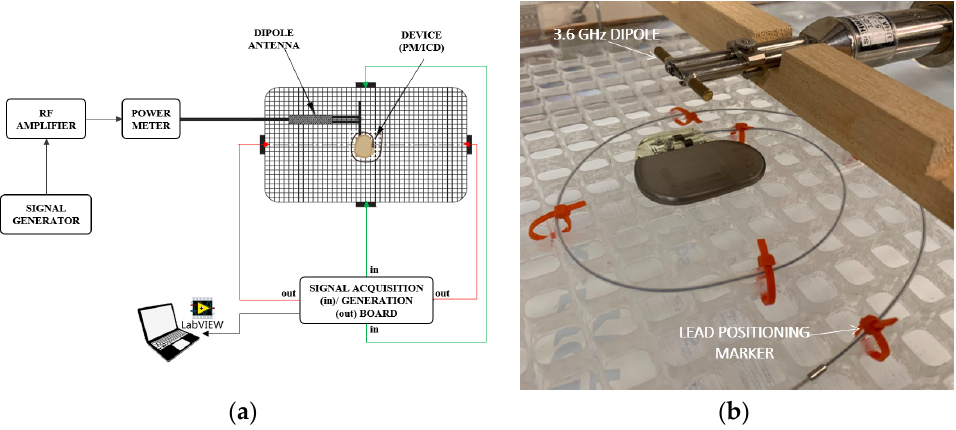
Figure 1. ( a ) Schematic representation of the test setup according to ISO 14117. ( b ) Highlight of one test conducted on a